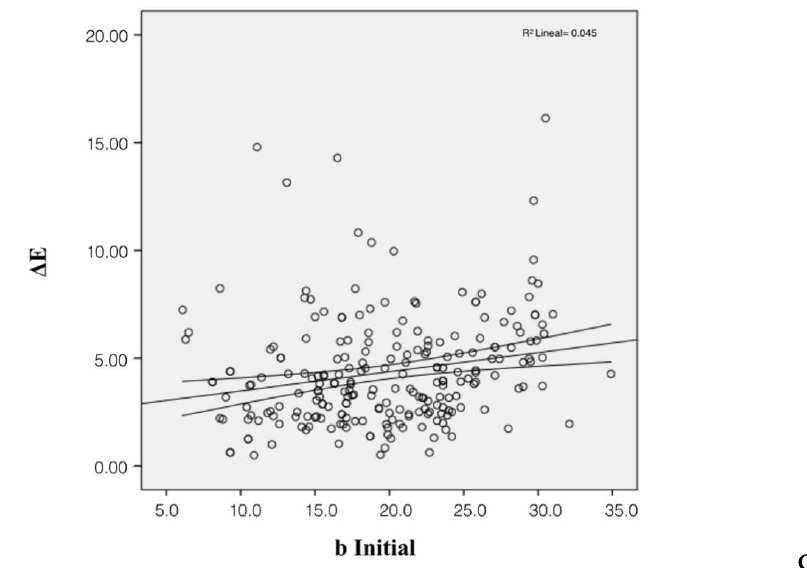
Figure 2. (A ) Linear correlations between ΔE and color parameter L*. ( B ) Linear correlations between ΔE and color parameter a*. ( C ) Linear correlations between ΔE and color parameter b*. In the forward stepwise linear regression model (R squared 0.149; p < 0.001), initial ΔE was